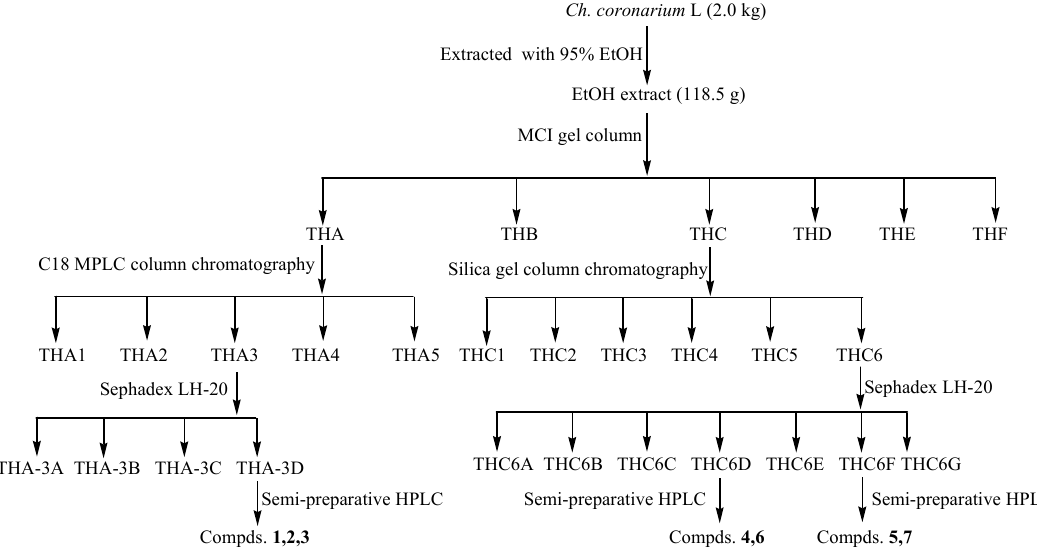
Figure 3. The procedure for the extraction and isolation of compounds from Ch. coronarium L.